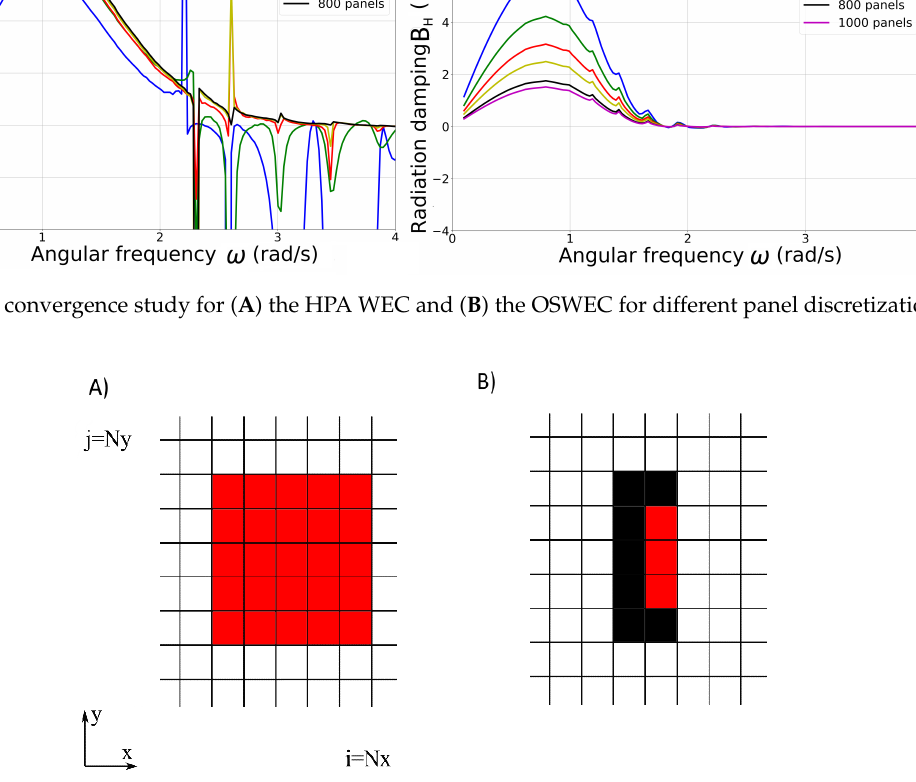
Figure 3. Detail from the sponge layer technique employed in MILDwave to mimic the behaviour of the WEC. In Subplot ( A ), the HPA WEC is represented by an N x = 5 × N y = 5 cell grid configuration. In Subplot ( B ), the OSWEC is represented by an N x = 2 × N y = 5 grid cell configuration. Black cells indicate fully reflective cells, while the red cells are assigned a specific wave absorption coefficient.